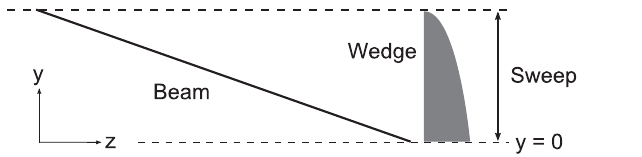
FIG. 1. Side view in real space as a beam with vanishing spot size approaches the wedge.